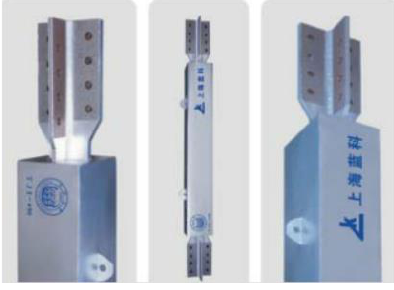
Figure 8. Physical object.